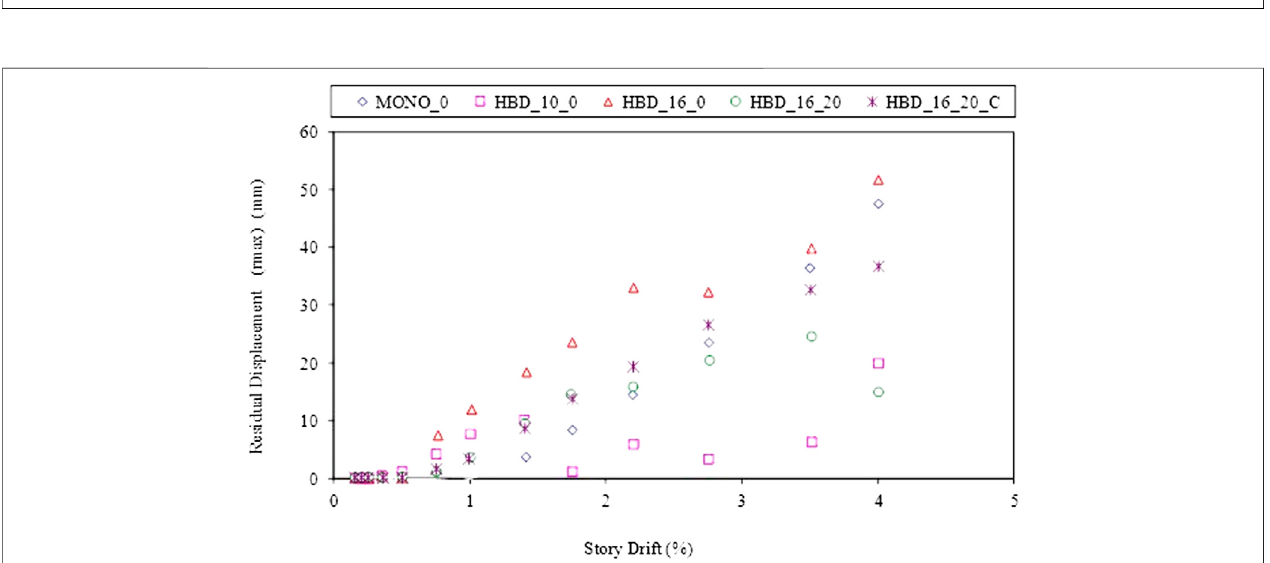
FIGURE 13 | The relative energy dissipation ratios vs. story drift response.